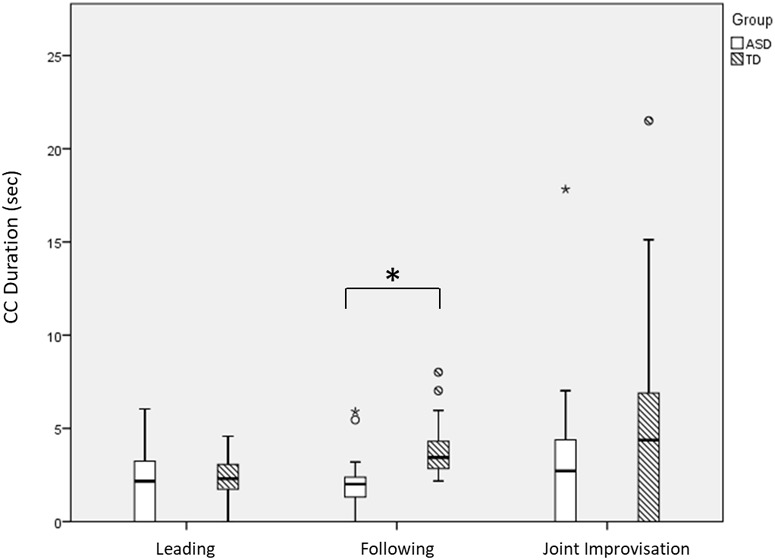
Participants’ average CC duration. When entering CC periods, TD participants maintained them longer than ASD participants (main effect of Group). Large asterisks represent p < 0.05 group differences. Boxplots: the solid line represents the median of the distribution; the outlines of the box represent the interquartile range, or 25th–75th percentiles; the whiskers represent the upper and lower quartiles, excluding outliers; small points and asterisks represent outliers and extreme outliers, respectively.